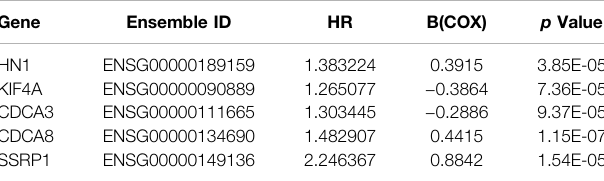
TABLE 3 | The detailed results from multivariate COX survival analysis of the selected prognostic